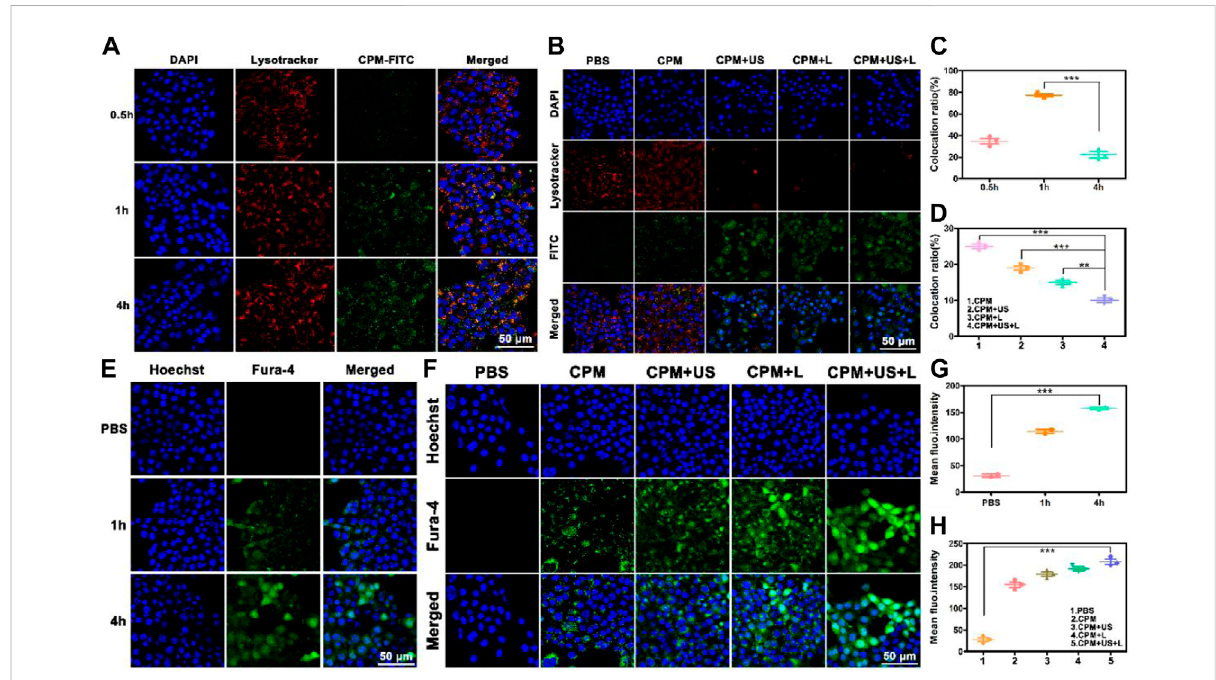
FIGURE 4 (A) The CLSM of CPM NPs (labeled with FITC, 20 μ g ml − 1 ) with lysosomes in 4T1 cells after incubation with CPM NPs for 0.5, 1, and 4 h, respectively. (B) TheCLSMofCPMNPs(labeledwithFITC,20 μ g ml − 1 )withlysosomesin4T1cellsbeingvarioustreatments. (C) Theco-locationratio of CPM NPs with lysosomes in 4T1 cells after incubated with CPM for 0.5, 1, and 4 h, respectively. (D) The co-location ratio of CPM NPs with lysosomes in 4T1 cells after various treatments. (E) Confocal images of 4T1 cells incubated with CPM NPs (20 μ g ml − 1 ) at different time points andstainedwithanintracellularCa 2+ indicator,Fluo-4AM(5 μ M). (F) Confocalimagesof4T1cellsbeingvarioustreatmentsafterincubatedwithCPM NPs (20 μ g ml − 1 ) for 4 h and stained with an intracellular Ca 2+ indicator, Fluo-4 AM (5 μ M). (G) Mean fl uorescence intensity (MFI) of intracellular Ca 2+ level in 4T1 cells. (H) MFI of intracellular Ca 2+ level in 4T1 cells after various